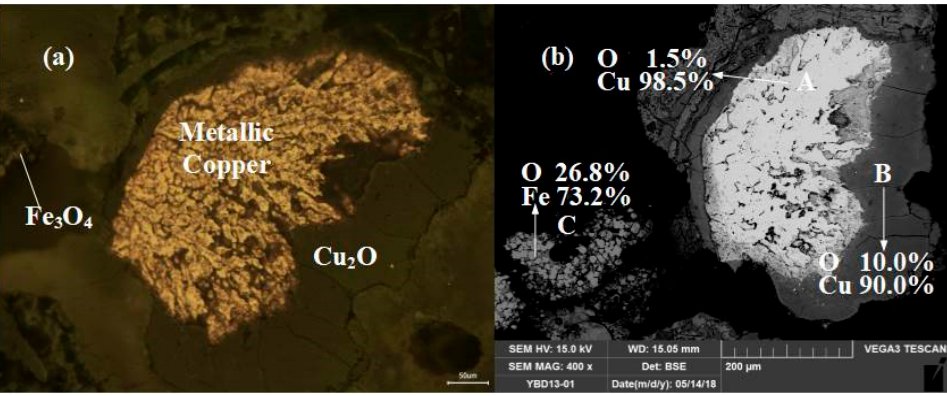
Figure 21. Optical micrograph ( a ) and SEM backscattered electron image ( b ) of YBD15. Sample YBD16: Metallic copper particles with Cu 2 O (cuprite) solid solution were visible in the field of view of the metallographic microscope, and the Cu 2 O (cuprite) solid solution appears dark in color. The slag matrix is a silicate containing small amounts of K, Fe, and Cu. As shown in Figure 22.